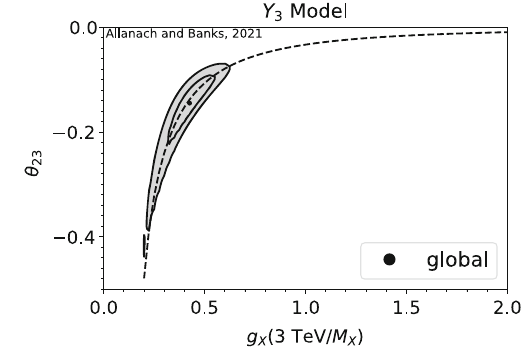
Fig. 3 Fit of electroweak and b → s μ + μ − data to the TFHM. This plotwasmadefromthedatapresentedintheancillaryinformationofthe arXiv version of Ref. [50]. The dot displays the best-fit point and the inner (outer) contours in the shaded region display the 67% (95%) con- fidence level (CL) contours. The dashed line shows our characterisation of the fit The relevant TFHM parameters for us are M X , g X and θ 23 .